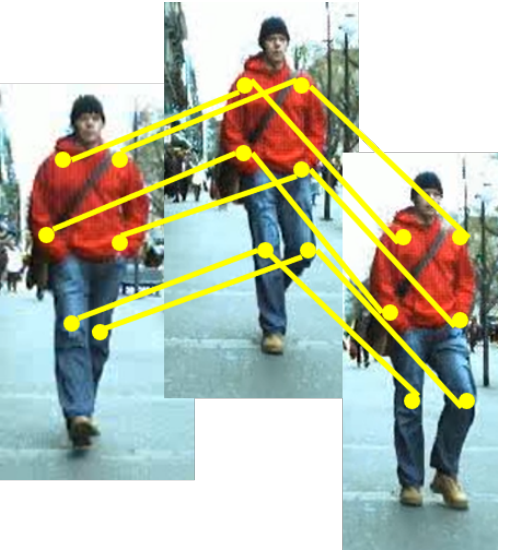
Figure 7. Motion segmentation. The trajectory points are projected across multiple frames.